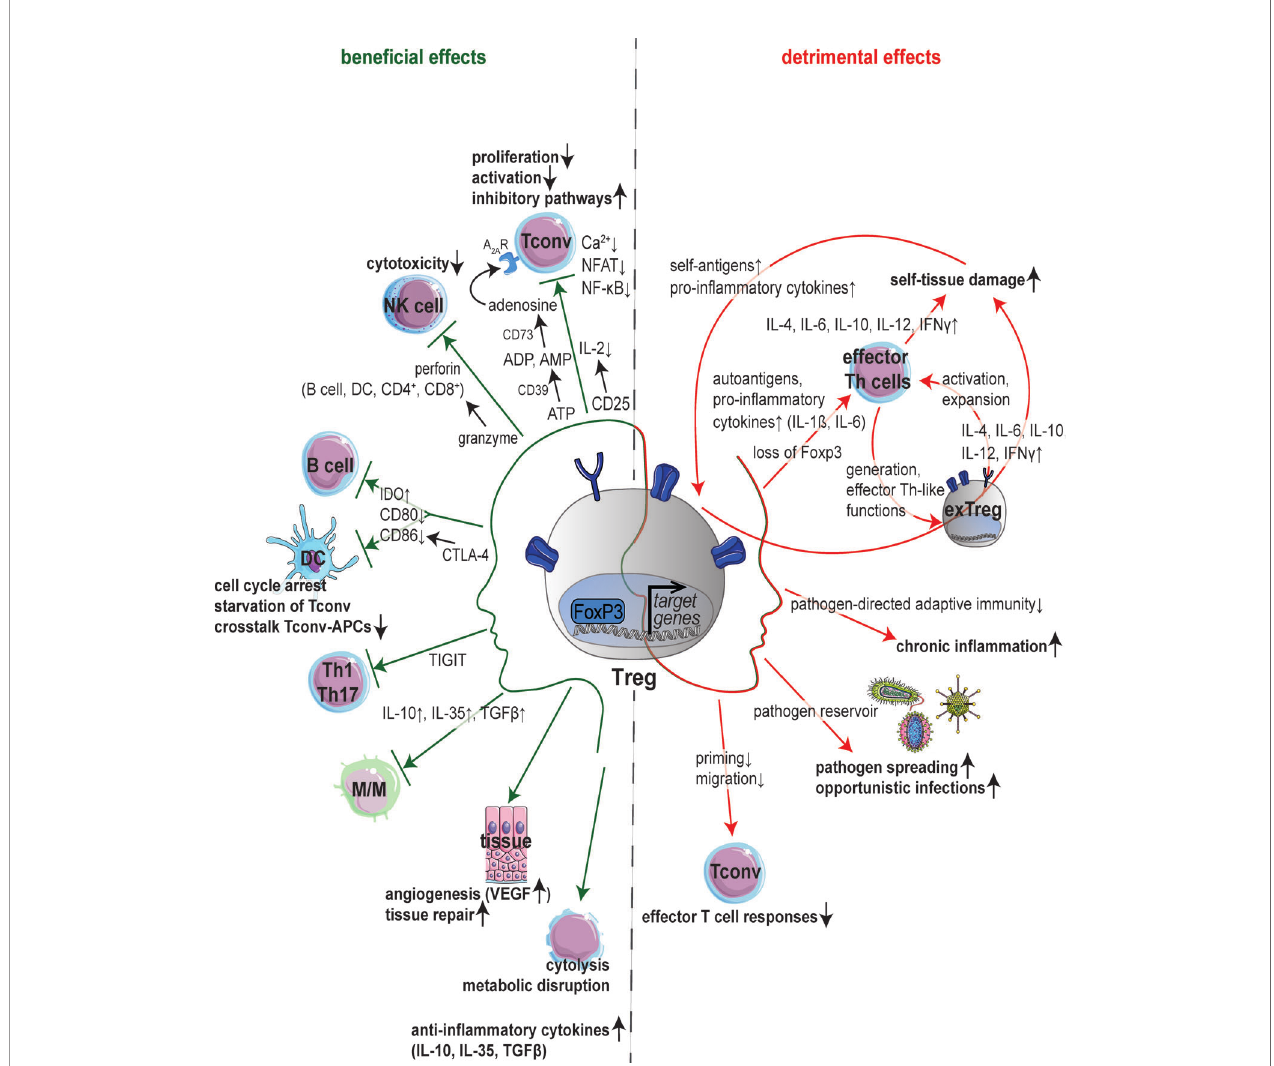
FIGURE 1 | Janus-faced nature of Tregs. Schematic overview of molecular mechanisms underlying the regulation of immune cells and immune responses by regulatory T cells (Tregs). Anti-infective functions are mainly mediated by suppression of immune cells (left): Expression of CD25 leads to consumption of interleukin (IL)-2 inhibiting activation and proliferation of conventional T cells (Tconv). Suppression of Tconv can also be mediated by adenosine production via the ectoenzymes CD39 and CD73. Besides, Tregs are able to suppress T cell receptor (TCR)-induced Ca 2+ , NFAT and NF- k B signaling. Dendritic cells (DCs) and B cells are in fl uenced by cytotoxic T-lymphocyte antigen 4 (CTLA-4) which binds CD80/CD86 and increases the expression of indoleamine 2,3-dioxygenase (IDO) resulting in starvation of Tconv next to cell cycle arrest and decrease in crosstalk between Tconv and antigen-presenting cells (APCs). Tregs can induce the death of effector cells (B cells, DCs, CD4 + and CD8 + cells) in a granzyme-perforin-dependent manner. The co-inhibitory molecule T cell immunoreceptor with Ig and immunoreceptor tyrosine-based inhibitory motif domains (TIGIT) suppresses T helper (Th) 1 and Th17 cell responses. Tregs can also induce angiogenesis via vascular endothelial growth factor (VEGF) or target tissue cells directly. Further immunosuppressive effects of Tregs are mediated by cytokines (IL-10, IL-35, TGF b ), cytolysis or metabolic disruption. By contrast, Tregs can support in fl ammation (right) by a multi-layered feed-forward loop promoting the generation of ‘ exTreg ’ cells adapting Th-like functions, which in turn stimulate activation and expansion of autoreactive Th effector cells. Loss of immunosuppressive capacity adapting phenotype and functionality of Th cells is also reported upon loss of forkhead box protein 3 (Foxp3) in Tregs. Also, Tregs inhibit effector T cell responses thereby promoting chronic in fl ammation, pathogen spreading and opportunistic infections acting as pathogen reservoir. APCs, antigen-presenting cells; CTLA-4, cytotoxic T-lymphocyte antigen 4; DCs, dendritic cells; Foxp3, forkhead box protein 3; IDO, indoleamine 2,3-dioxygenase; IL, interleukin; M/M, monocytes and macrophages; TIGIT, T cell immunoreceptor with Ig and immunoreceptor tyrosine-based inhibitory motif domains; Tconv, conventional T cells; TCR, T cell receptor; TGF b , tumor growth factor b ; Tregs, regulatory T cells; VEGF, vascular endothelial growth